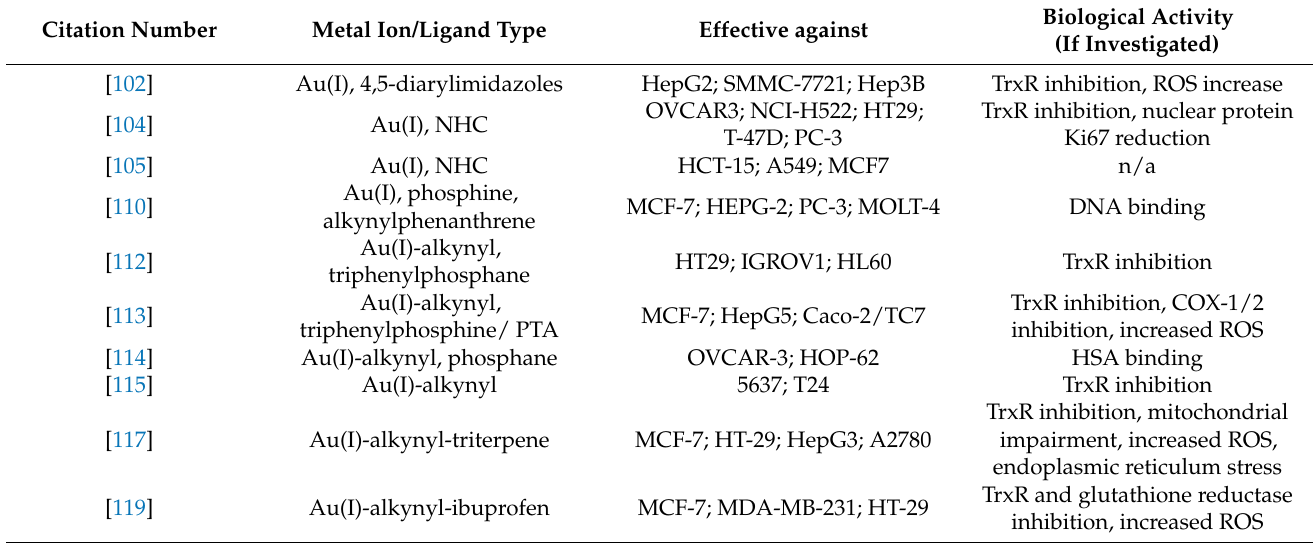
Table 4. Summary of the gold complexes presented.